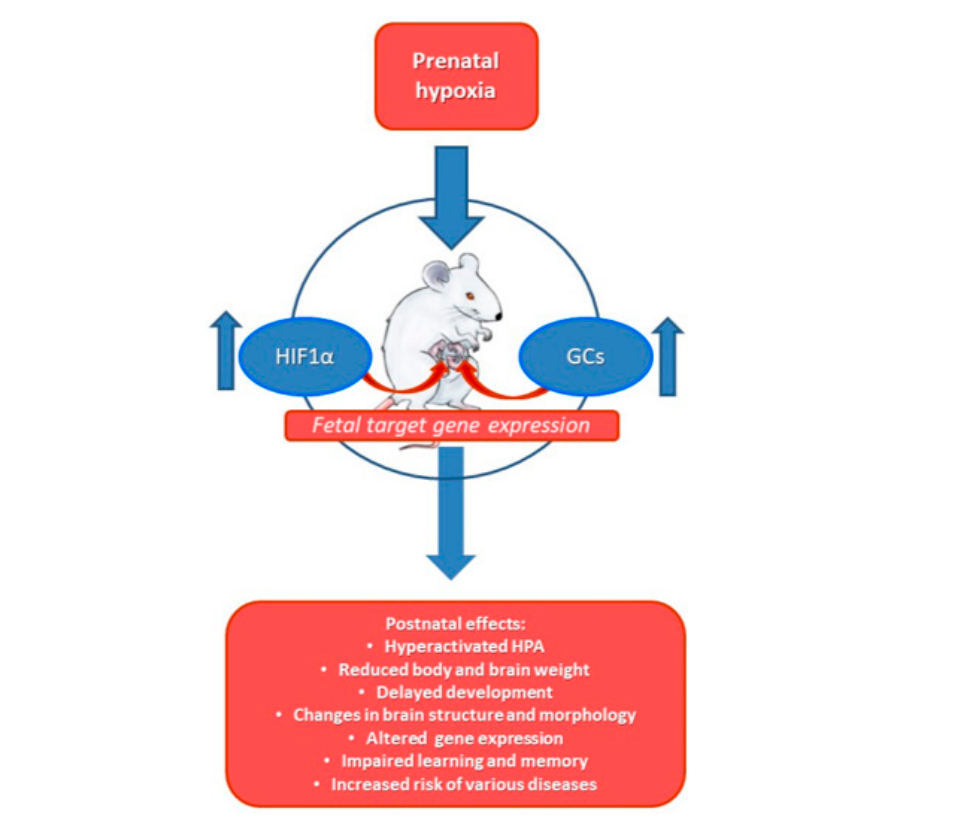
Figure 3. Prenatal hypoxia leading to changes both in the maternal and fetal HPA results in increased levels of GCs and HIF-1 α in the developing fetus. This will lead to changes in expression of a number of fetal genes, and affects the developmental program of the new-born organism, predisposing it to various pathologies in later life. It will also modify the response of various organs of the newborn to GCs, affecting their response to various stressors in later life.